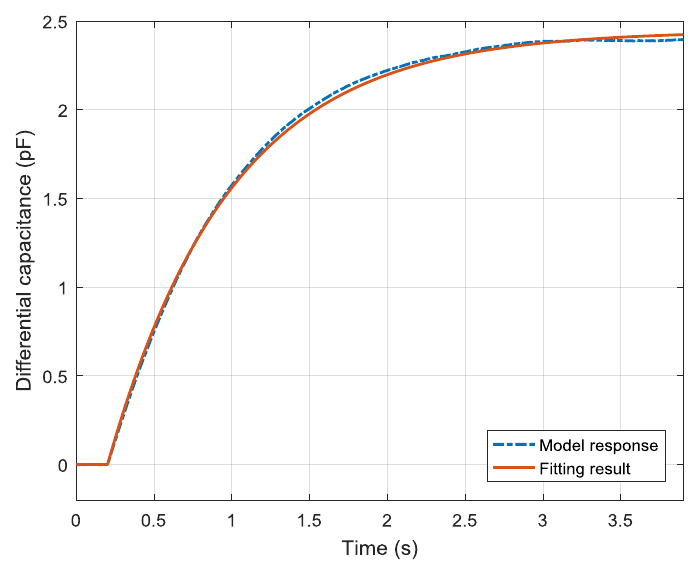
Figure 10. System identification result of the experimental data.